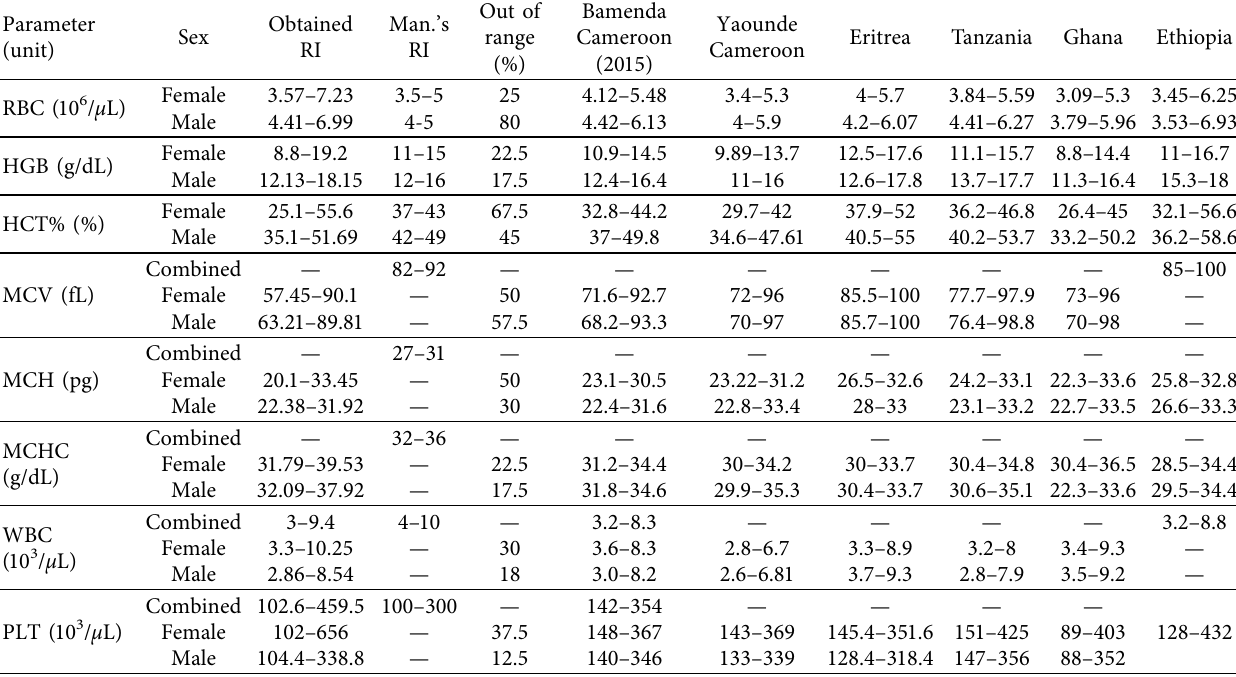
Table 5: Comparison of obtained reference intervals and reference intervals in Yaounde and other African countries.